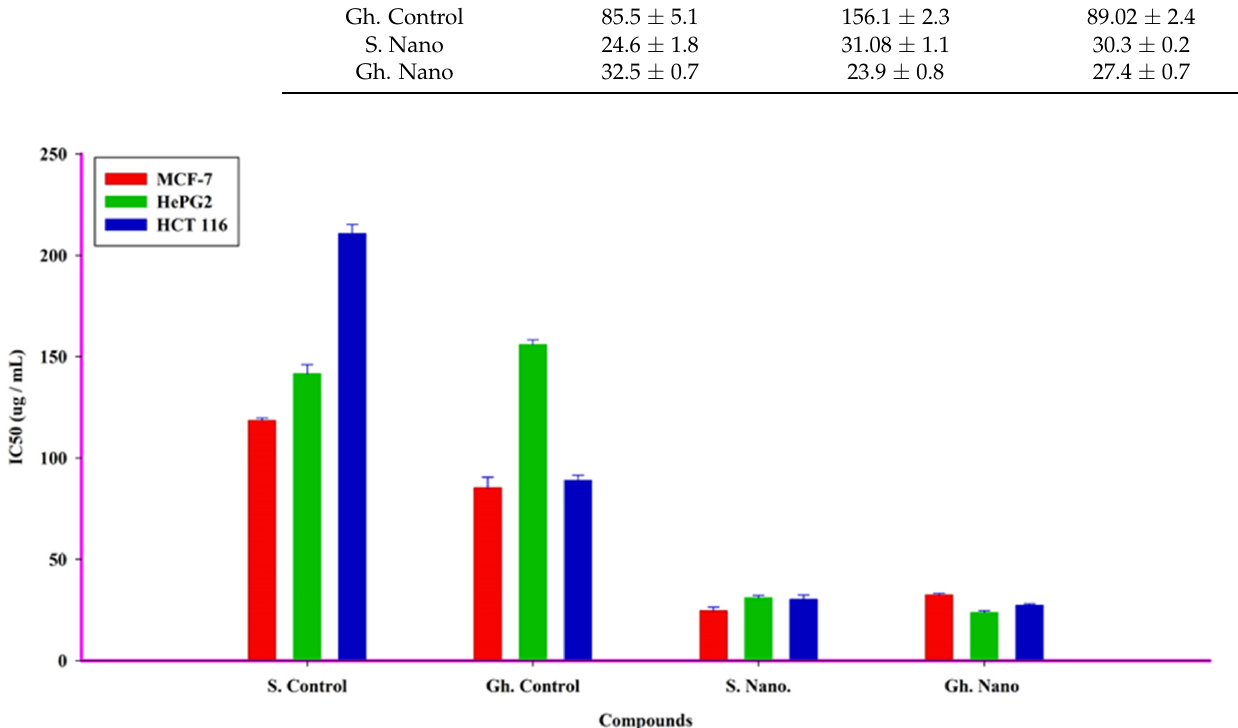
Figure 7. Cytotoxic effects of honey (Gh = Forest and S = Sider) and nanoparticles on different human cell lines.